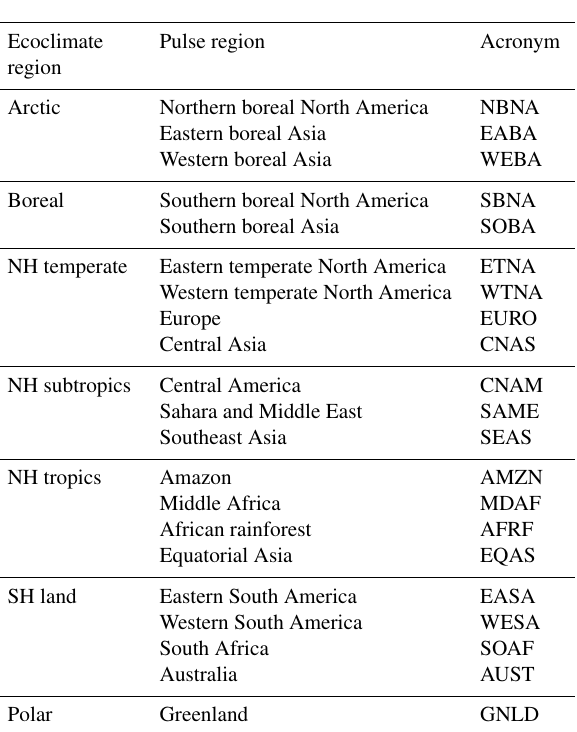
Table 2. GEOS-Chem regions that comprise the ecoclimate regions shown in Fig.